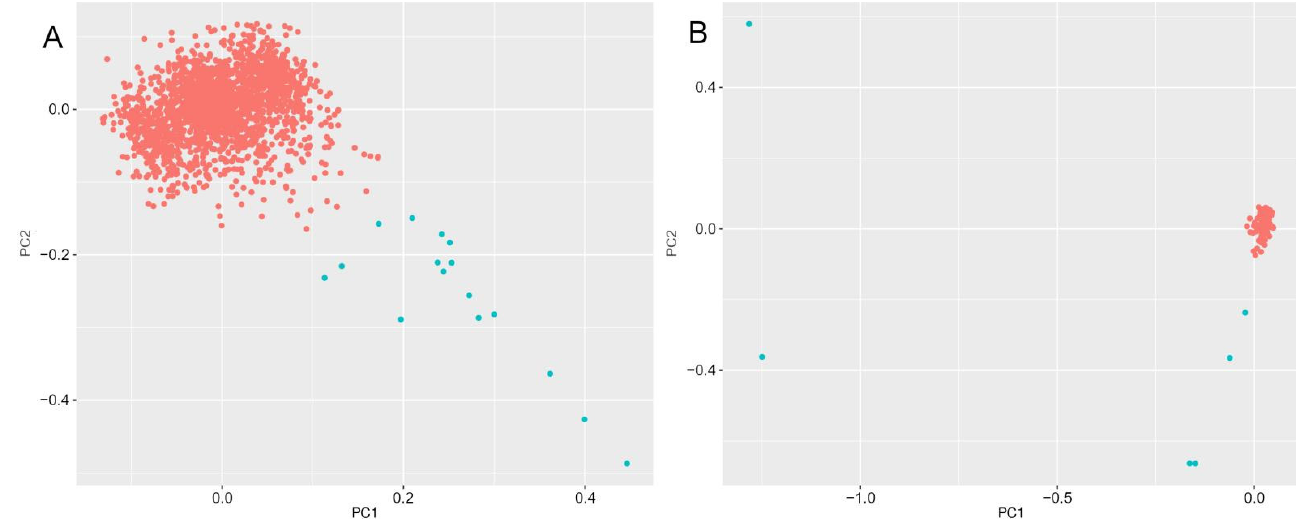
Figure 1. Principal component analysis of the substructure of the studied population: ( A ) ESSE ‐ Ivanovo and RPS ‐ CP; and ( B ) RPS ‐ E. The core cluster is colored red, and outliers are colored blue.